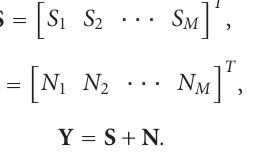
Figure 1: Measurement setup for the conference scenario.